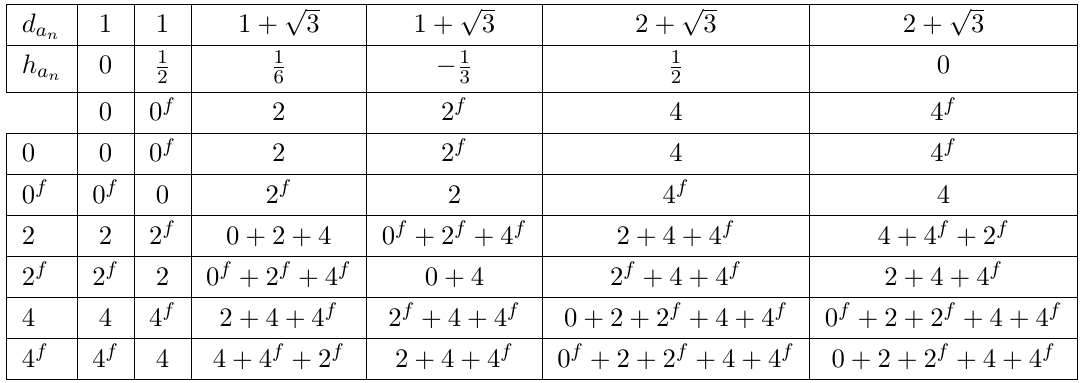
Table 1 . Quantum dimensions, topological spins, and fusion rules of F renamed to 0 and 0 f